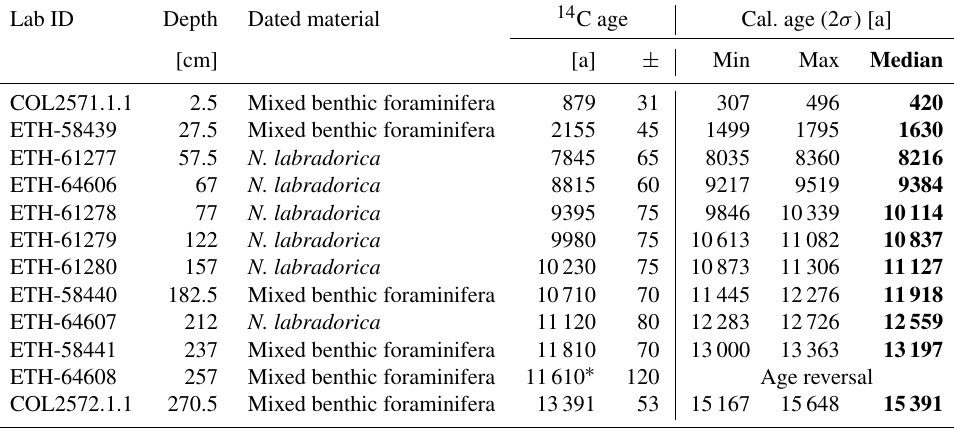
Table 1. AMS radiocarbon measurements and calibrated ages applying the Marine13 calibration curve (Reimer et al., 2013) and an aver- aged regional (cid:49)R = 98 ± 37 years (calib.qub.ac.uk). All measurements, apart from the measurements at 2.5 and 270.5cm (CologneAMS, University of Cologne), were carried out at ETH Zürich. Median ages (in bold) were used for the age–depth